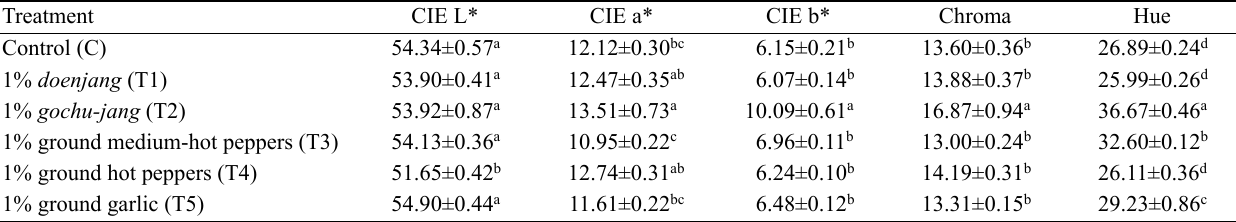
Table 3. Color traits of fermented sausages as affected by the seasonings addition 1